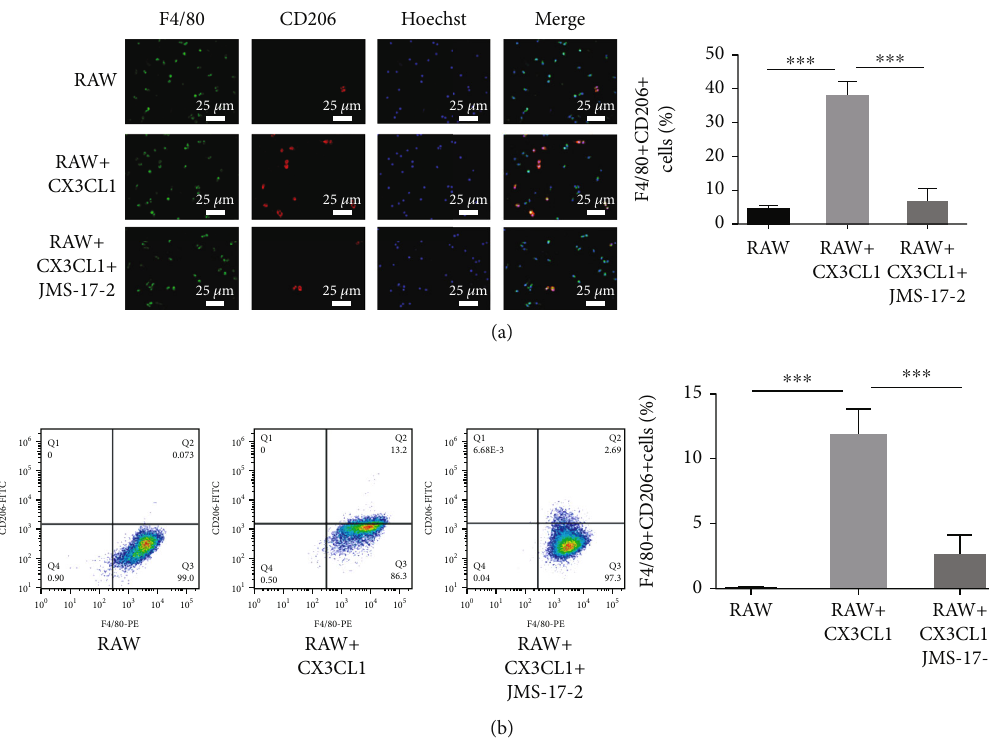
Figure 6: Recombinant CX3CL1 signi fi cantly increased the proportion of M2 macrophages, while this e ff ect was reversed by adding JMS- 17-2 as measured by immuno fl uorescent staining (a) and fl ow cytometry (b). “ ∗∗∗ ” indicates p < 0 : 001 . RAW: RAW264.7